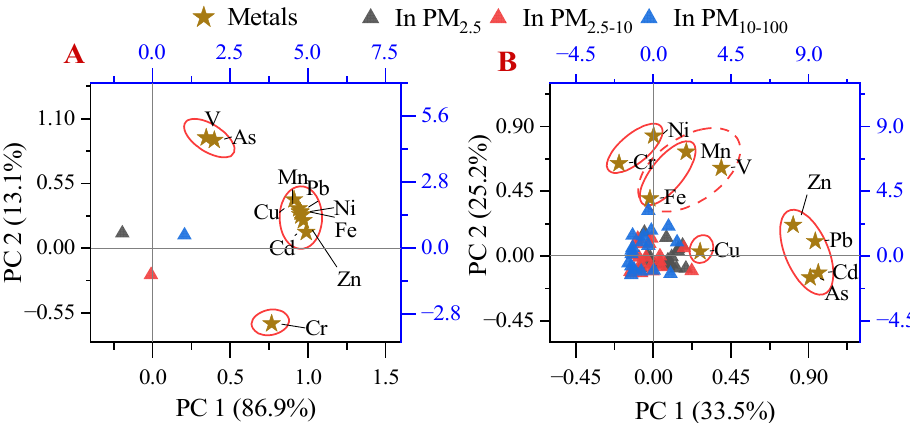
Figure 3. Principal component analysis of the metals in the e-waste dismantling park ( A ) and the surrounding residential area ( B ); principal components and related rotational load are in black, and the scores of the classification are in blue .